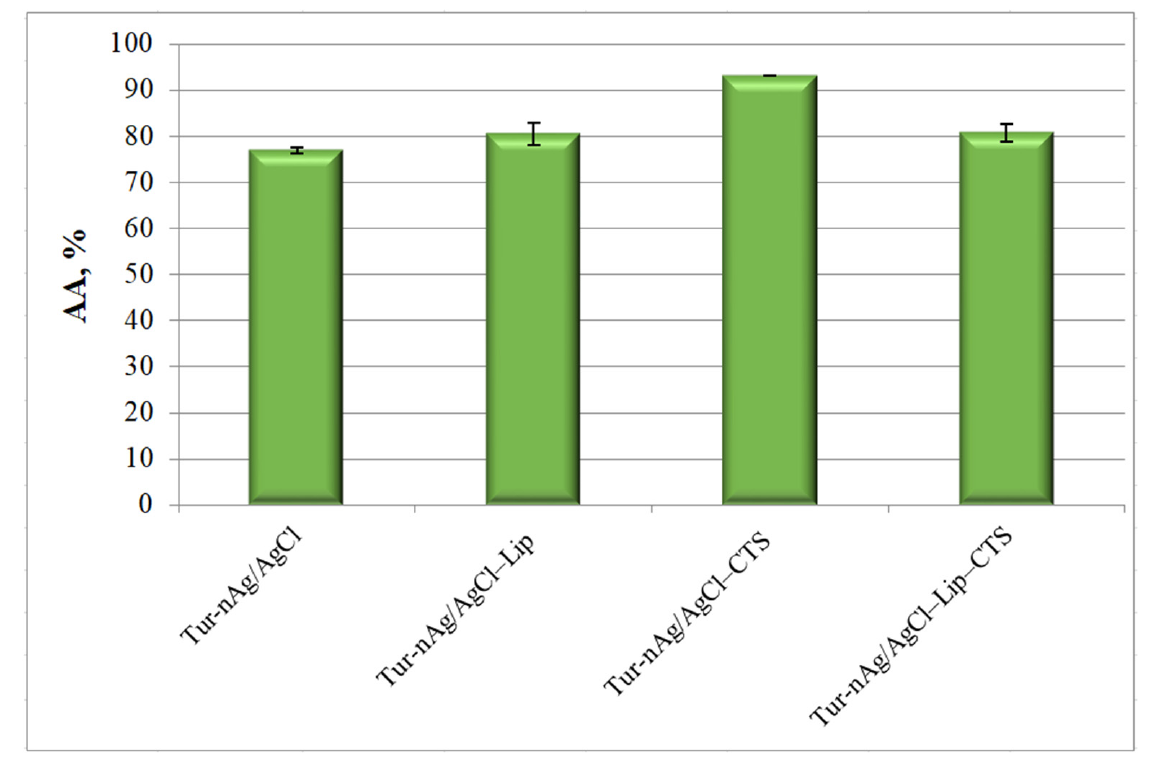
Figure 8. The antioxidant activity of silver-based materials.